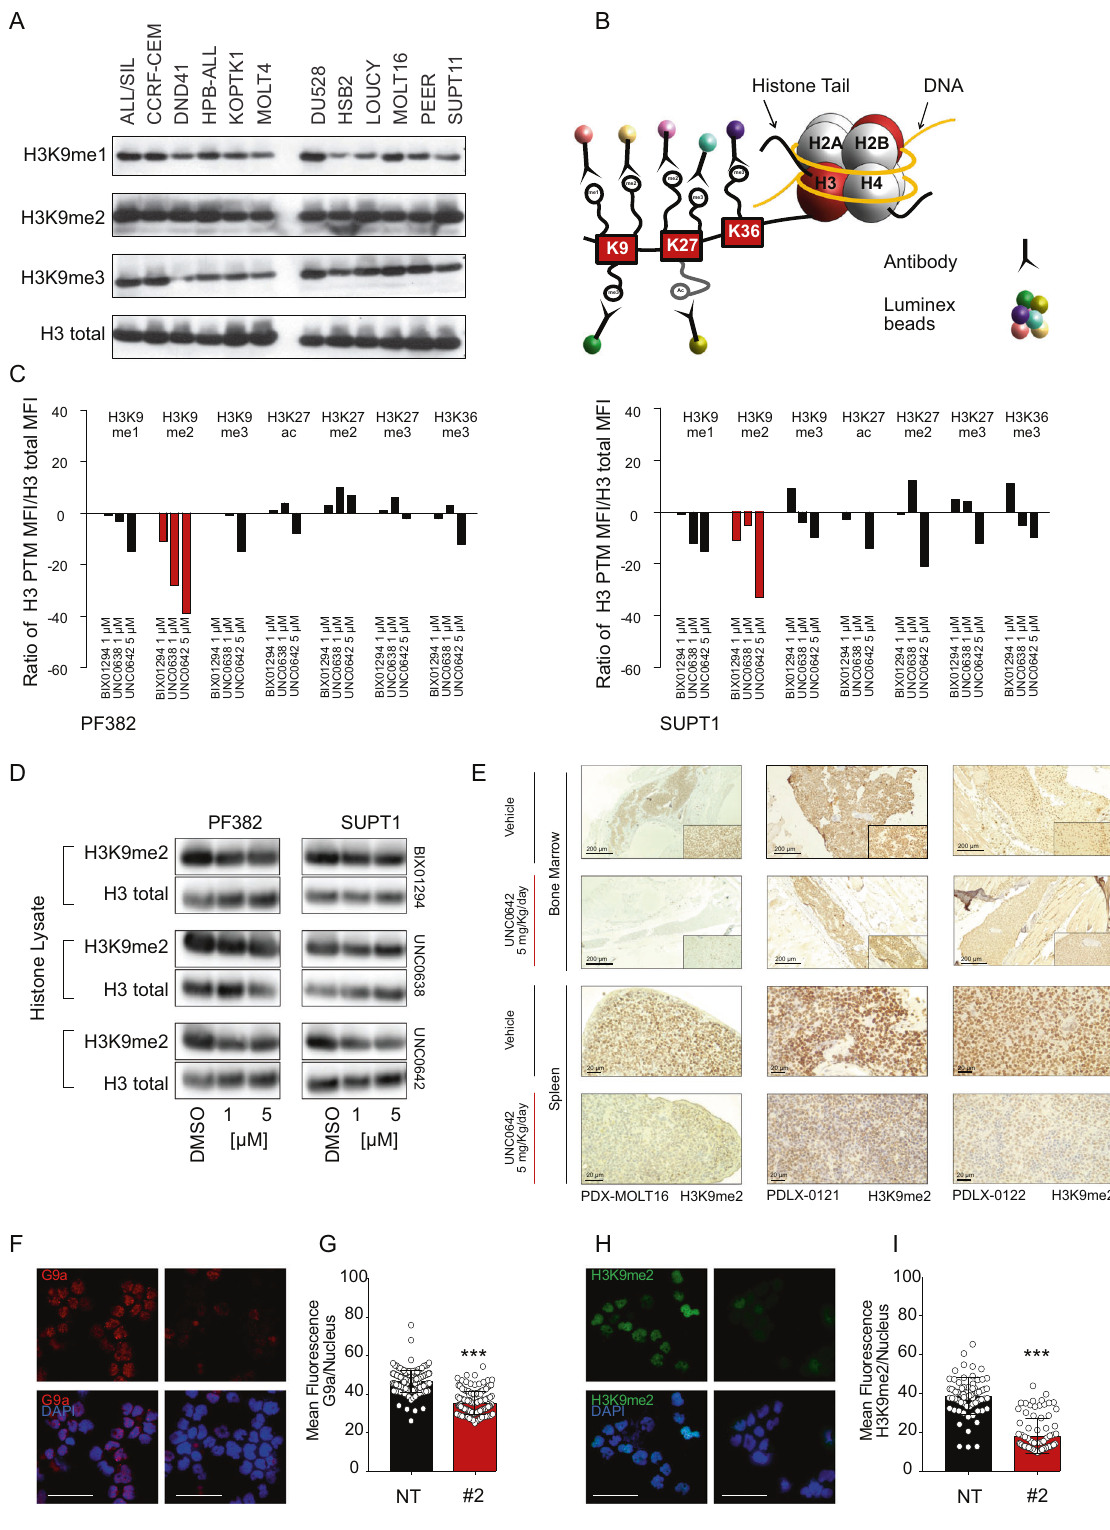
(Fig. 4D), and demonstrated that EHMT2 /G9a inactivation caused a decrement in sestrin2 expression in multiple T-ALL cell lines. Because sestrin2 is a stress-induced protein involved in different cellular adaptive responses by regulating ER stress, in fl ammation, and autophagy [25], we decided to explore the contribution